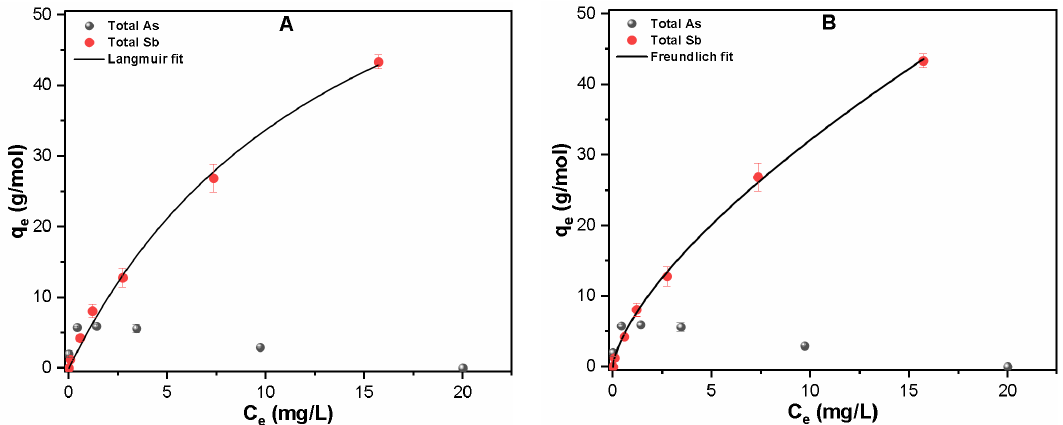
Figure 6. Under the initial As and Sb concentrations of (0.1 to 10) mg/L, pH: 7 and 0.1 mM FC dose, showing the ( A ) Langmuir; and ( B ) Freundlich fitting of the As and Sb coagulation data for the quaternary system. Table 3. Parameters of the Langmuir and Freundlich adsorption models for Sb species on FC precipitates in the quaternary system.